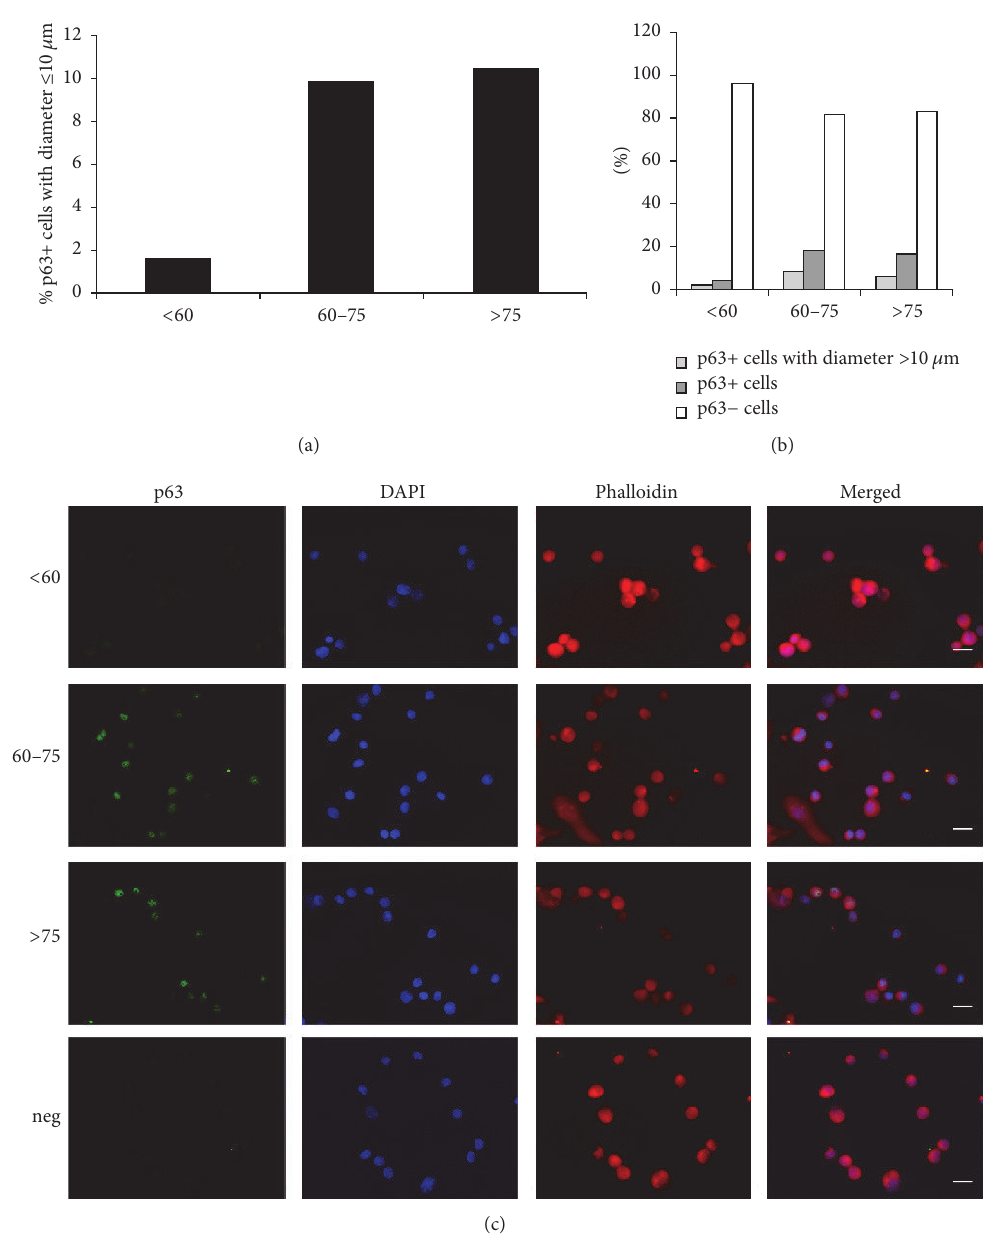
Figure4:Quantitativeimmunofluorescence(q-IF)ofp63inLSCpools.(a)Histogramshowsthepercentofp63+cellswithdiameters ≤ 10 𝜇